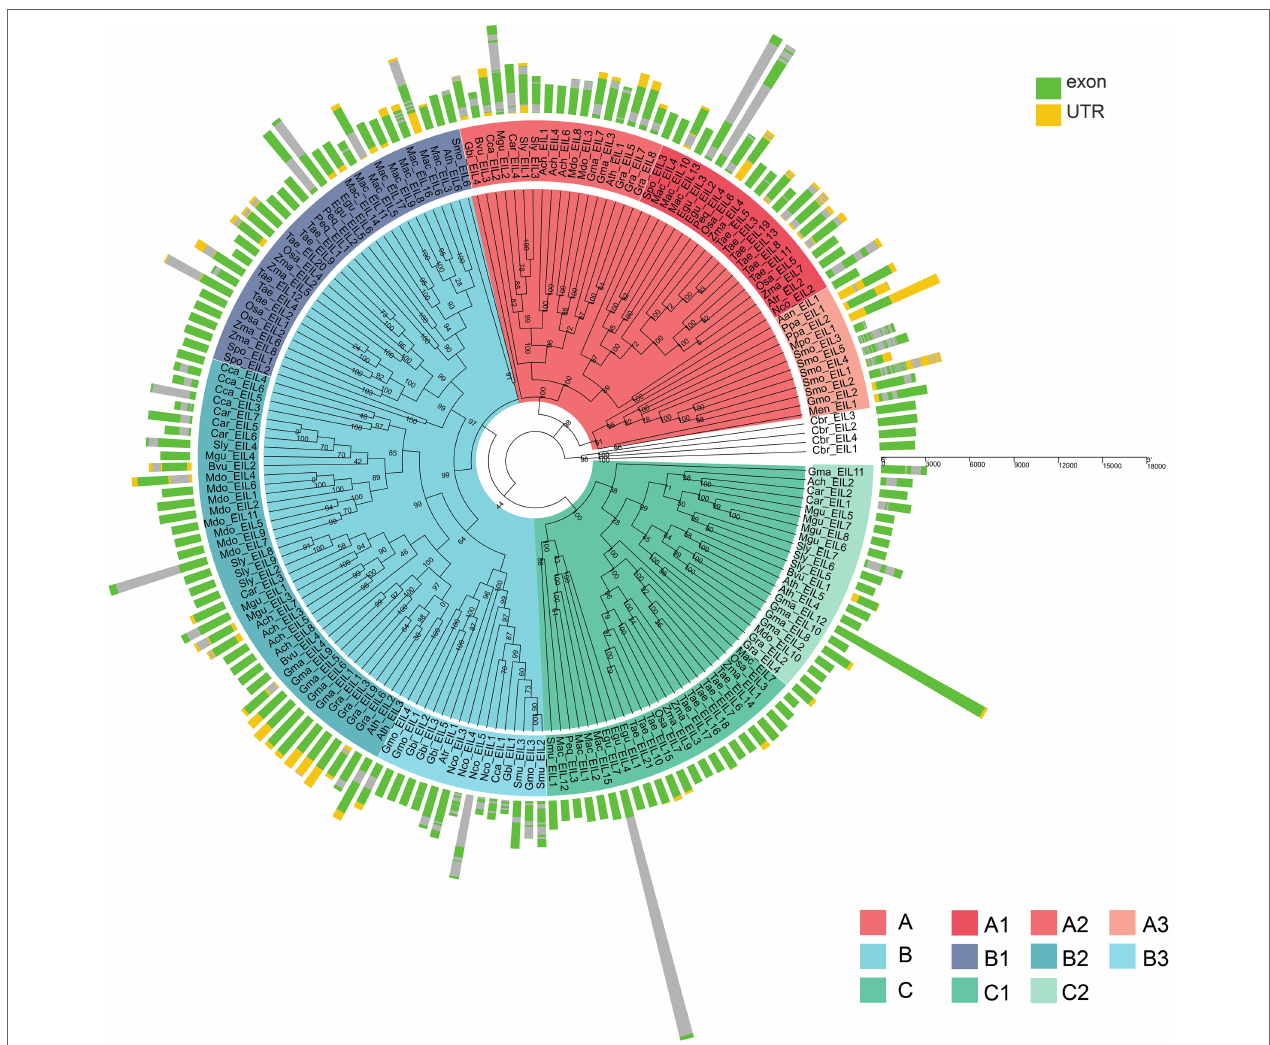
FIGURE 5 | The exon-intron structure of 182 EIN3/EILs genes. Green boxes indicate untranslated 5 ′ - and 3 ′ -regions, yellow boxes indicate UTR, and the grey lines indicate